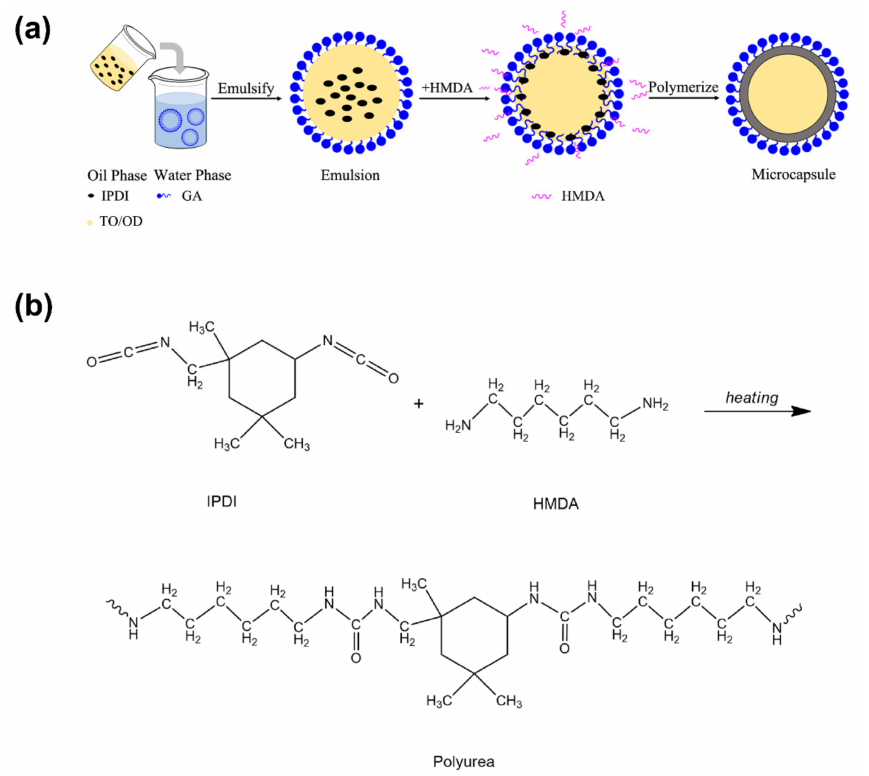
Figure 1. Schematic illustration of the preparation of microcapsules with antibacterial and thermoregulated function ( a ) and schematic diagram of the formation of polyurea (PU) polymer ( b